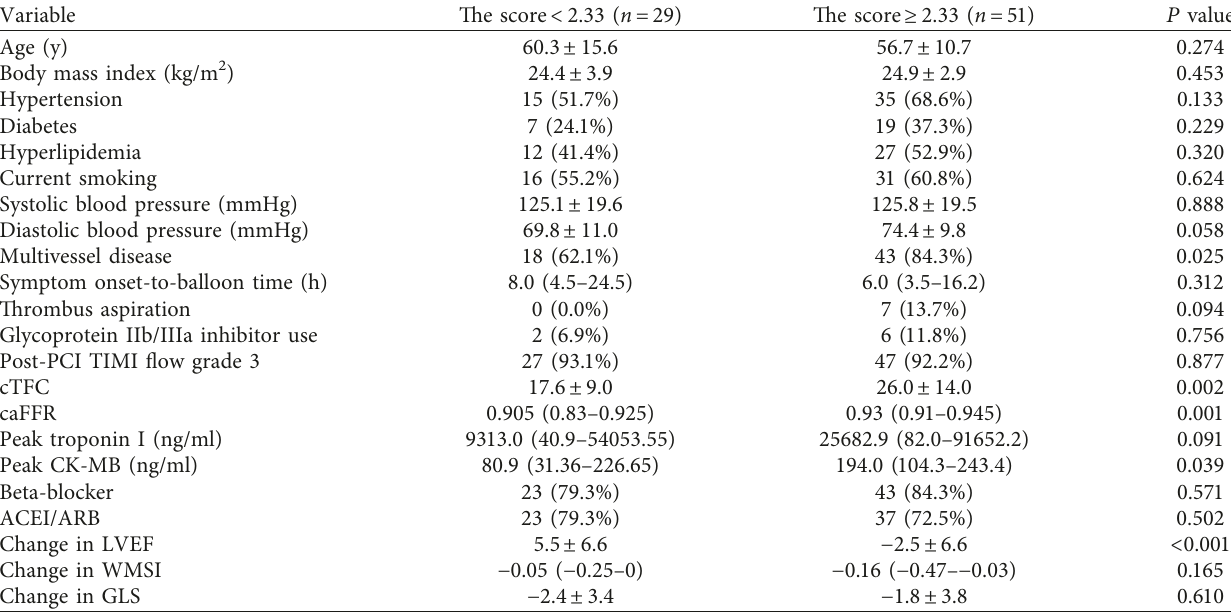
Table 5: Clinical variables and echocardiographic parameters of patients according to the optimal cutoff value for the predictive model. Variable